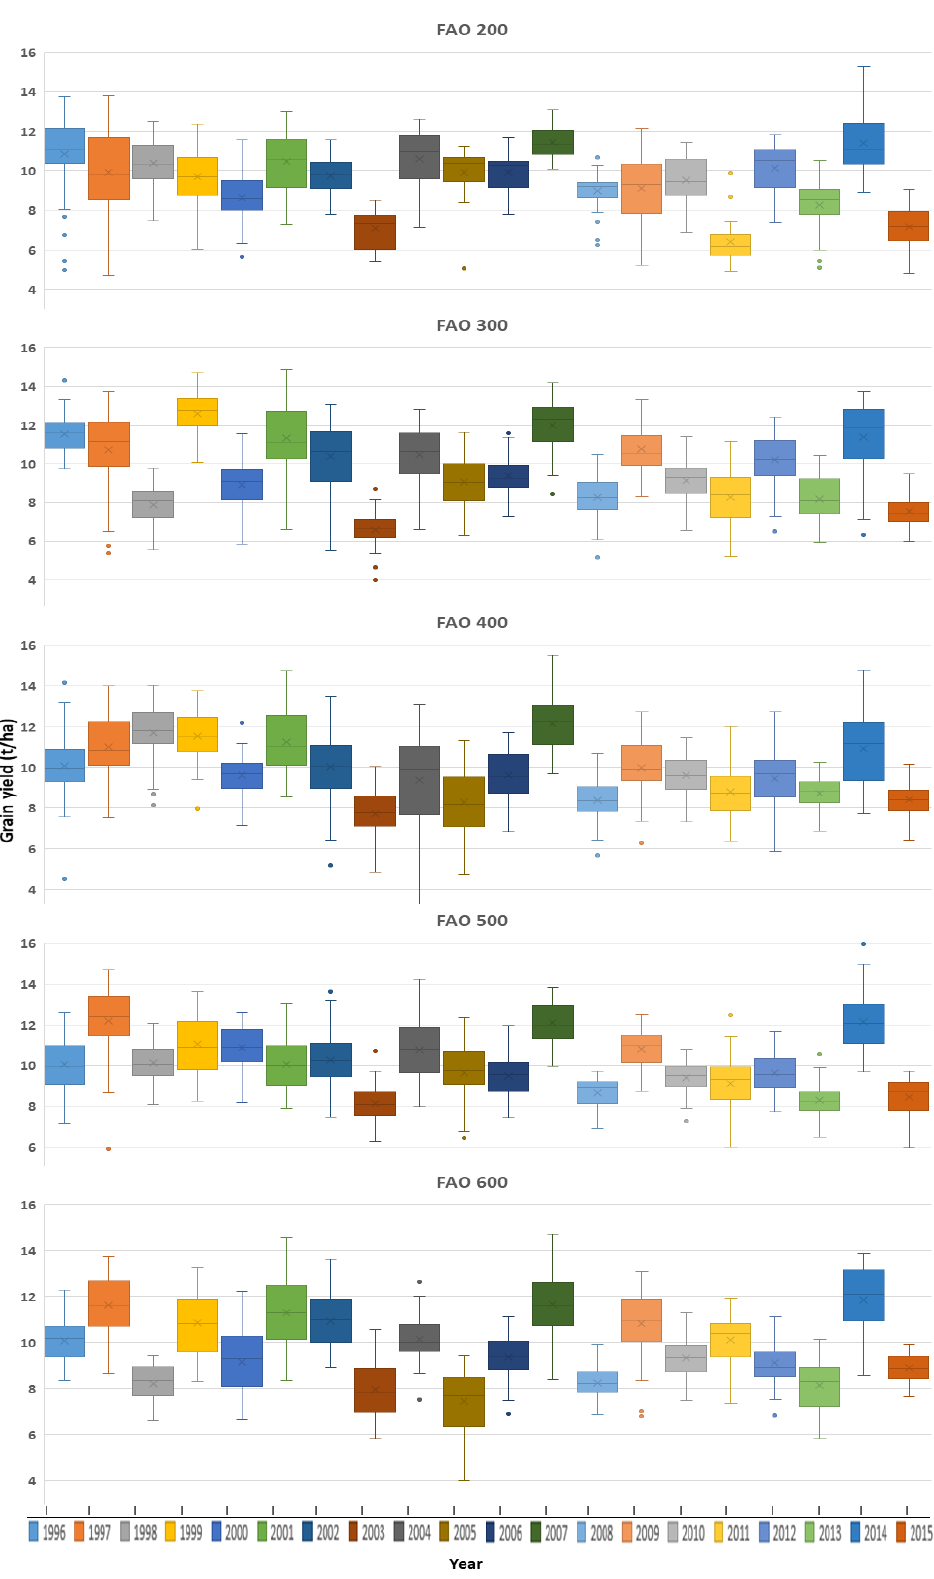
Figure 1. Boxplots of maize grain yield in the pre-registration experiment across five maturity groups (FAO 200–FAO 600) during the period of 1996 to 2015.